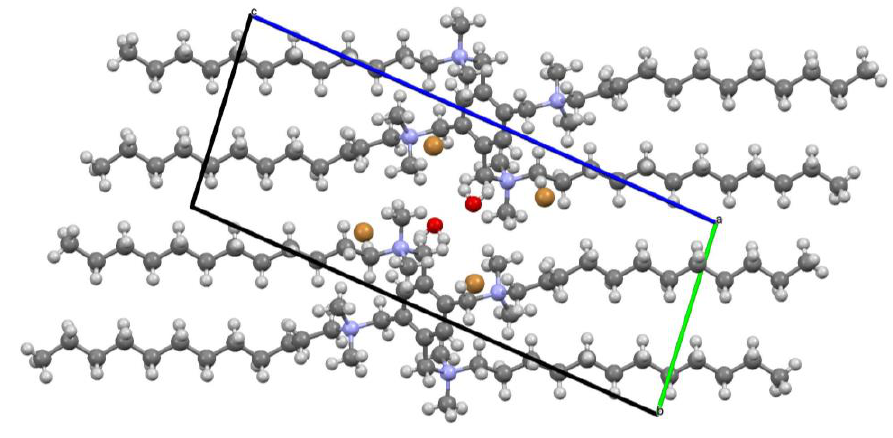
Figure 8. Crystal packing of compound 21 .